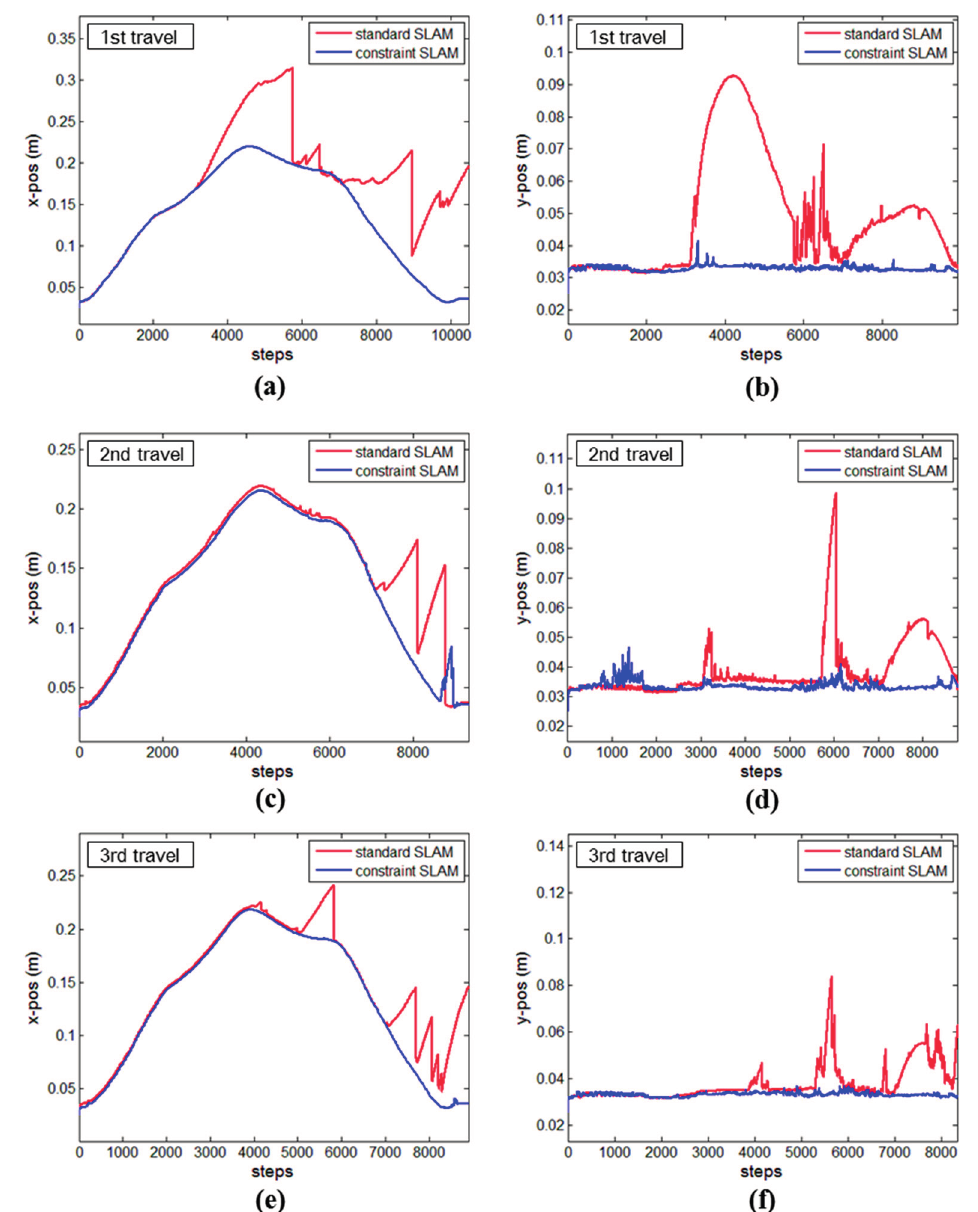
Figure 9. Uncertainty estimates of the seminar room test resulting from UKF SLAM without (red graphs) and with (blue graphs) the constrained approach: sideward direction ( a , c , e ); and forward direction ( b , d , f